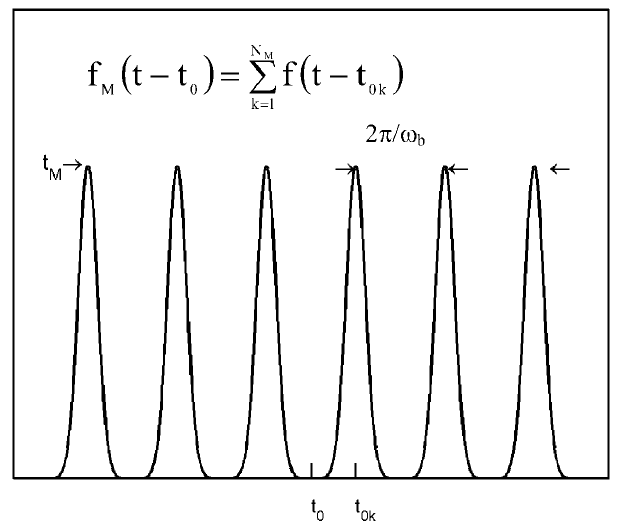
FIG. 9. (Color) The macropulse form-factor function (59) drawn (cid:1) 8 .FIG. 8. The macropulse pulse-shape function, composed of a for N M b